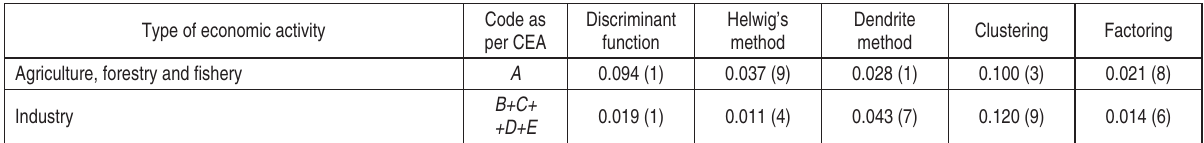
Table 4. Comprehensive analysis of economic sectors (by